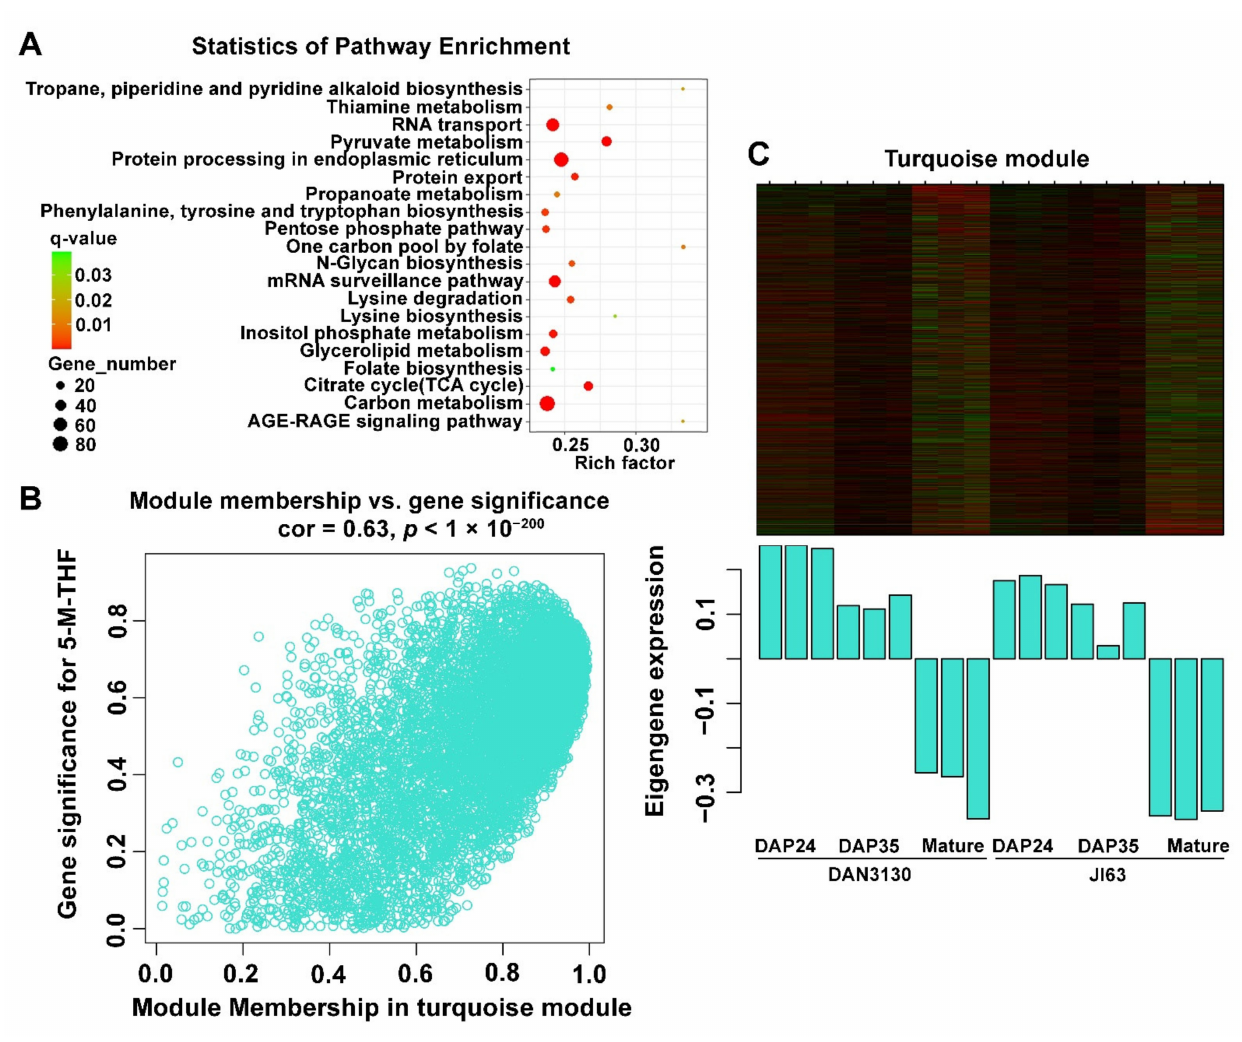
Figure 9. Bioinformatic analysis of the turquoise module. ( A ) KEGG enrichment of genes in the turquoise module; ( B ) The gene significance for 5-M-THF in the turquoise module (one dot represents one gene in the turquoise module); ( C ) Expression pattern of the genes and eigengenes of the turquoise